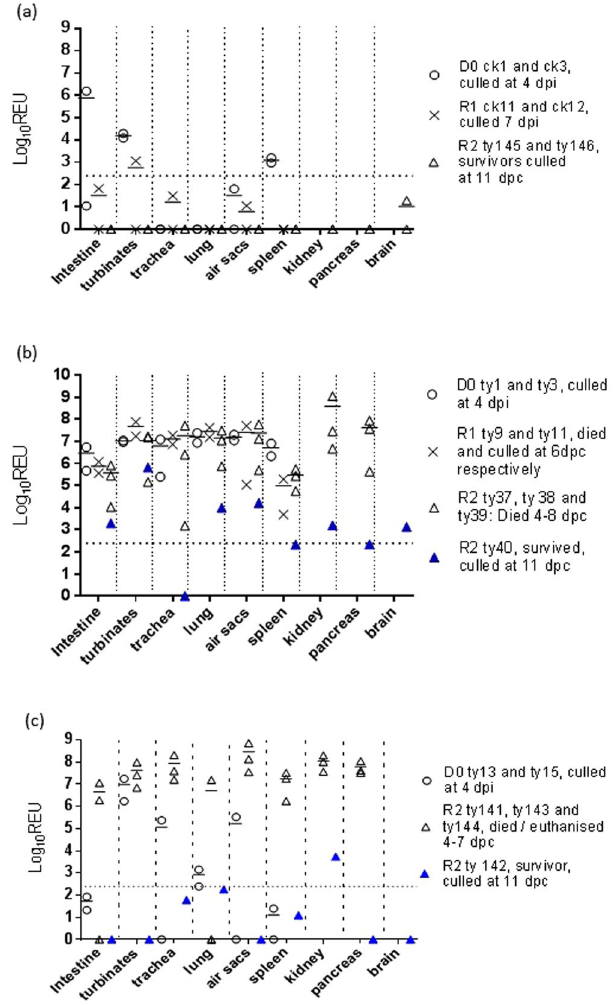
Figure 4. H7N9 viral RNA loads in organs obtained from infected birds. Horizontal bars indicate mean viral RNA loads when > 1 bird was sampled from a given group at a given time/time window. Broken horizontal is the cut-off threshold, as explained in Fig. 2. ( a ) Log 10 REU values in organs of D0 and R1 chickens (ck) plus R2 turkeys (ty) (8log 10 EID 50 direct infection of D0 chickens); ( b ) Log 10 REU values in organs of D0, R1 and R2 turkeys (8log 10 EID 50 direct infection of D0 turkeys); ( c ) Log 10 REU values in organs of D0 and R2 turkeys (6log 10 EID 50 direct infection of D0 turkeys). Pancreas and kidney specimens were first collected for RNA extraction only when mortality became apparent in R2 turkeys, with the brain specimens collected only at R2 cull (11